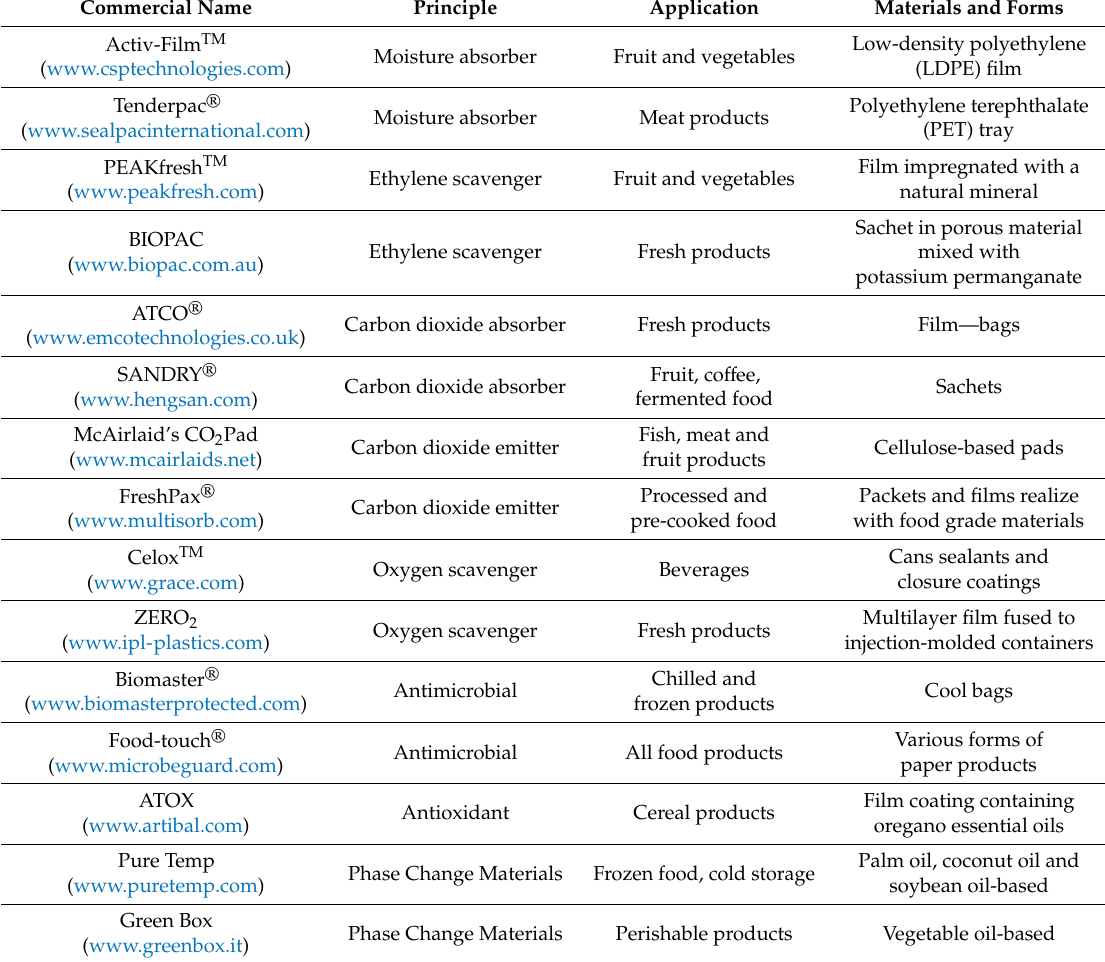
Table 1. Commercially available food active